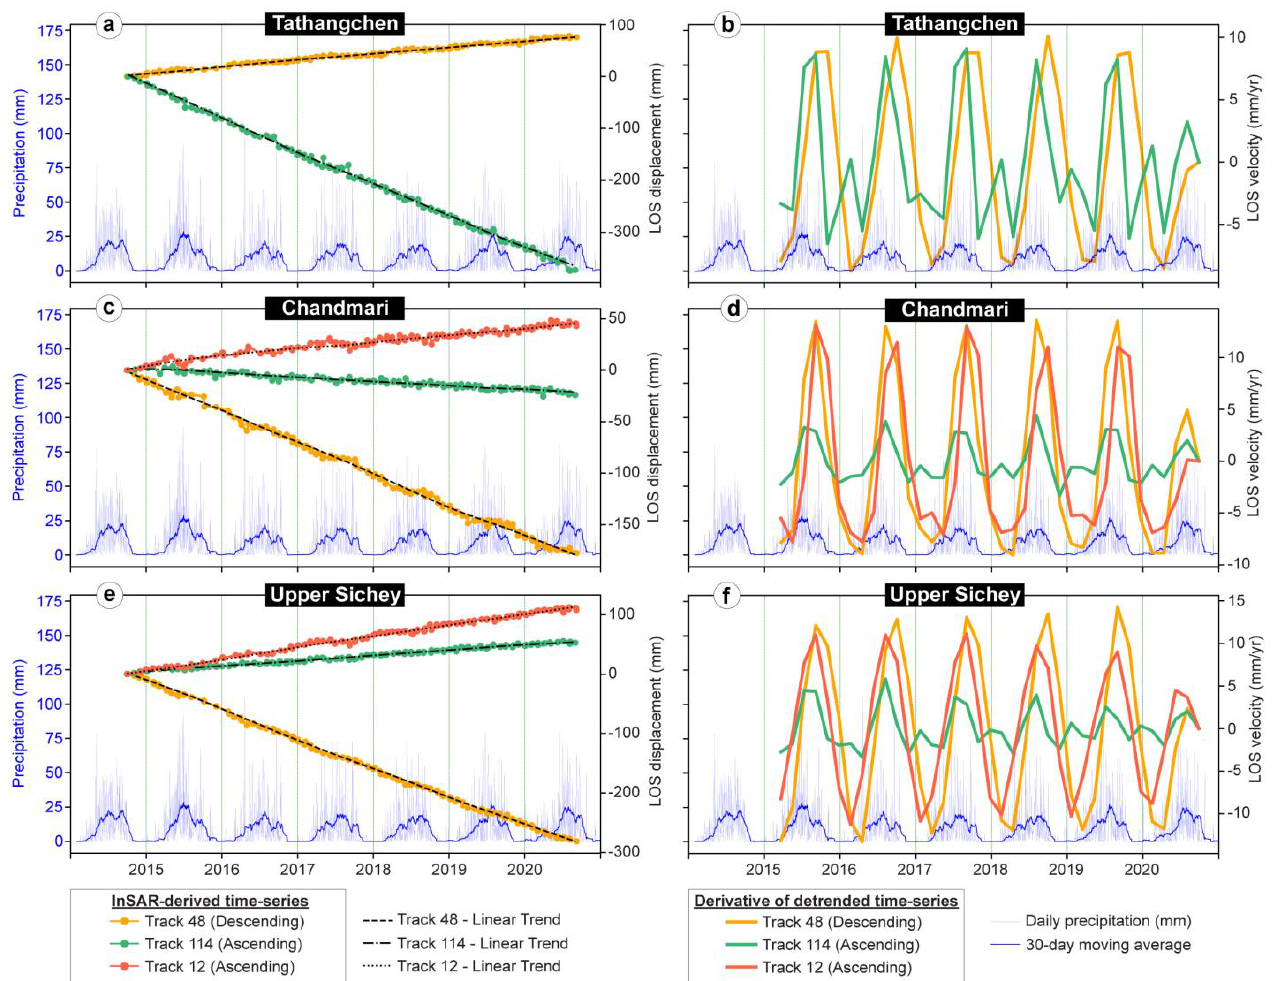
Figure 8. InSAR displacement time-series estimated from Sentinel-1 ascending tracks 114 (green) and 12 (red) and descending track 48 (orange) compared with daily precipitation time series obtained from India Meteorological Department. ( a , c , e ) show the InSAR-derived displacement time-series derived for Tathangchen, Chandmari and Upper Sichey landslides. Derivatives of the linearly detrended time-series obtained from different tracks are shown in ( b , d , f ) for each landslide. The daily precipitation and its 30-day moving average time series are shown in the bottom of each panel.